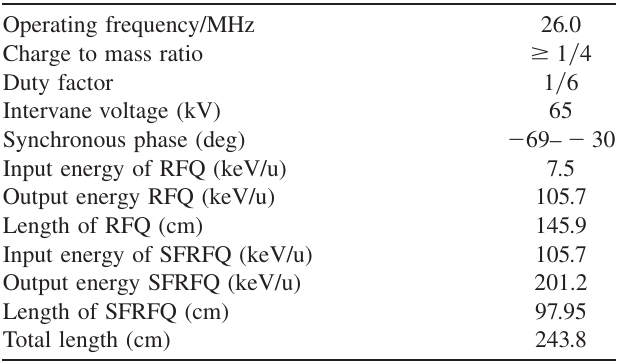
TABLE IV. Parameters of the coupled RFQ-SFRFQ cavity.